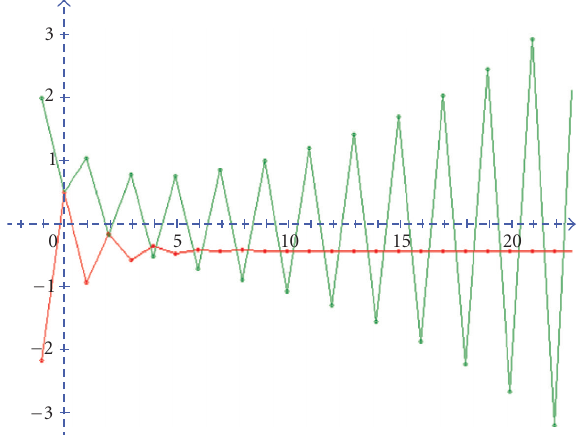
Figure 3.2. Regions with di ff erent behavior of x n and y n in the point D .